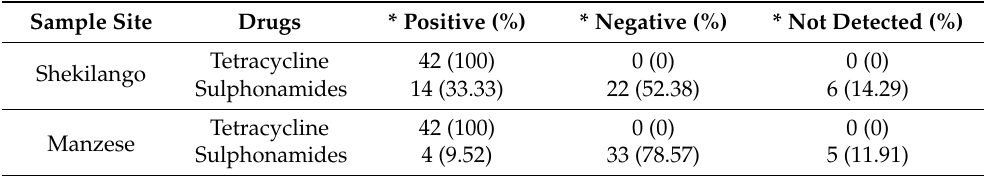
Table 1. The proportions of liver tissues positive for sulphonamides and tetracycline residues in Shekilango and Manzese markets.